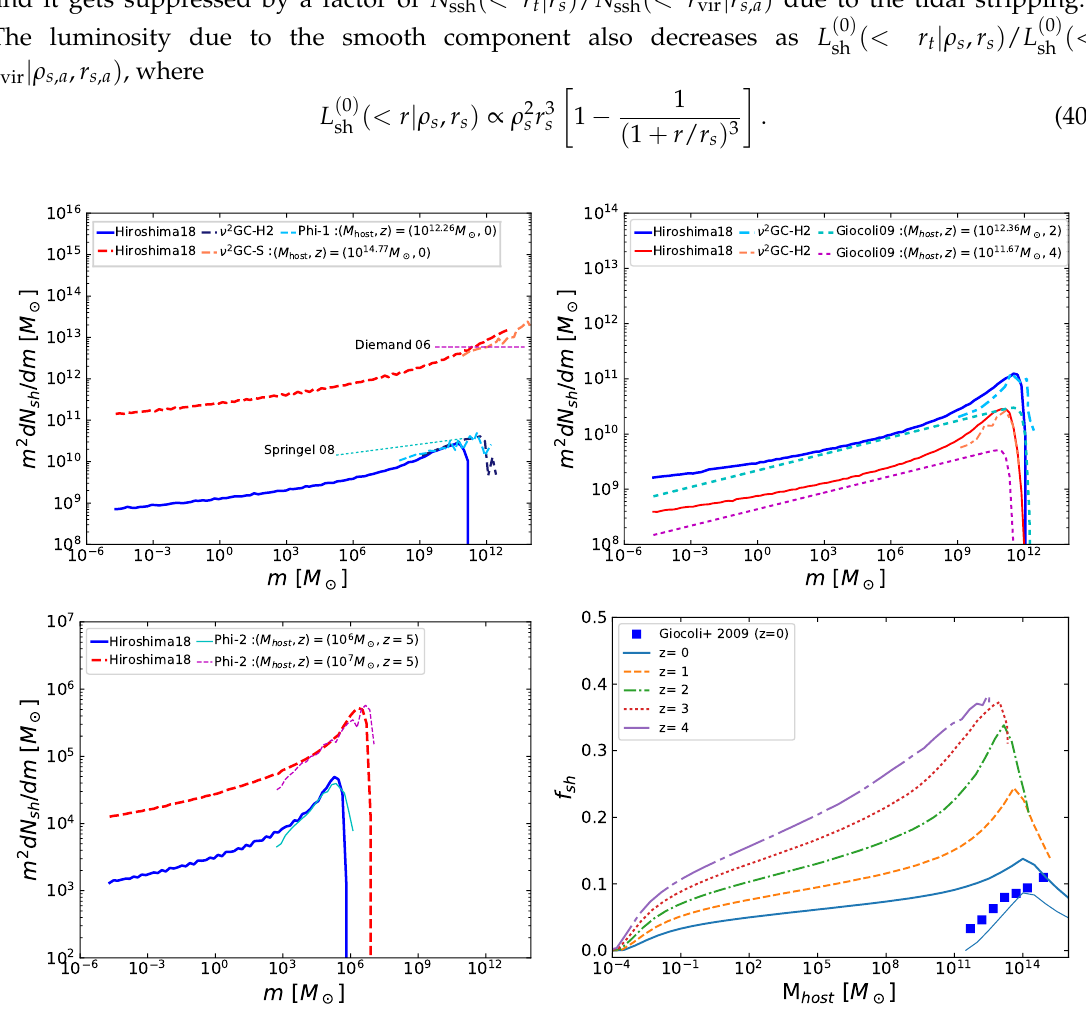
Figure 4. Subhalo mass function for galaxy ( M 200 = 1.8 10 14 M ) halos at z = 0 ( top left ), halos with 2.3 (cid:12) both of which would evolve to M 200 = 10 13 M 10 6 M and 10 7 M at z = 5 ( bottom left ). Results of the analytic models by Hiroshima et al. [50] (cid:12) (cid:12) are compared with those from the numerical simulations of similar halos and other fitting functions: Springel et al. [37], Diemand et al. [150] ( top left ), ν 2 GC H2 [126,127], Giocoli et al. [86] ( top right ) and Phi-2 (Ishiyama et al., in preparation; bottom left ). The bottom right panel shows the subhalo mass fraction f sh as a function of the host mass M 200 for various values of redshift z . The thin solid curve is for z = 0 but with lower mass threshold of 1.73 results shown as the